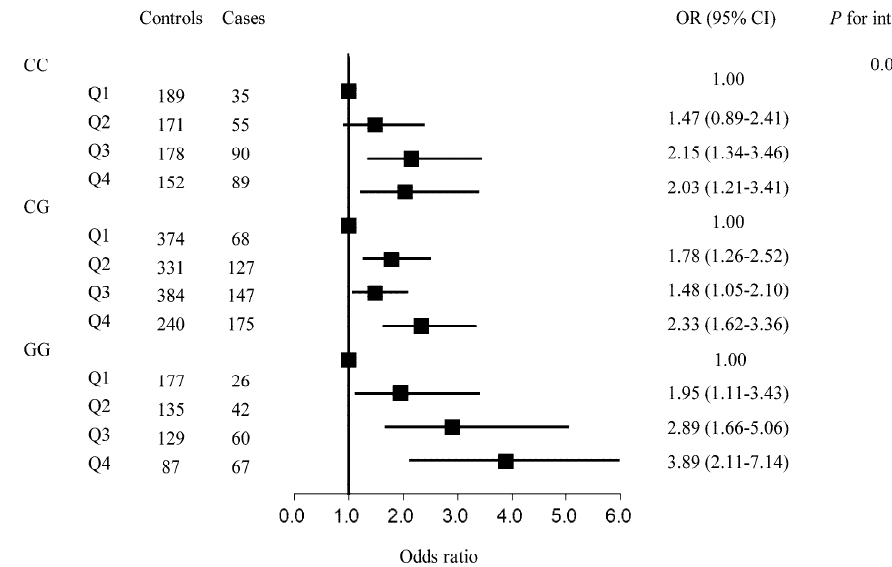
Figure 1. The association between carotid intima-media thickness (in quartiles) and ischemic stroke stratified by rs2910164 genotype. Results were adjusted for age (continuous), sex (male, female), educational levels (less than primary school, primary school, middle school, high school, college and above, missing), body mass index (continuous), alcohol consumption (current, former, never, missing), smoking status (current, former, never, missing), type 2 diabetes (yes/no), hypertension (yes/no), and coronary heart disease (yes, no, missing).